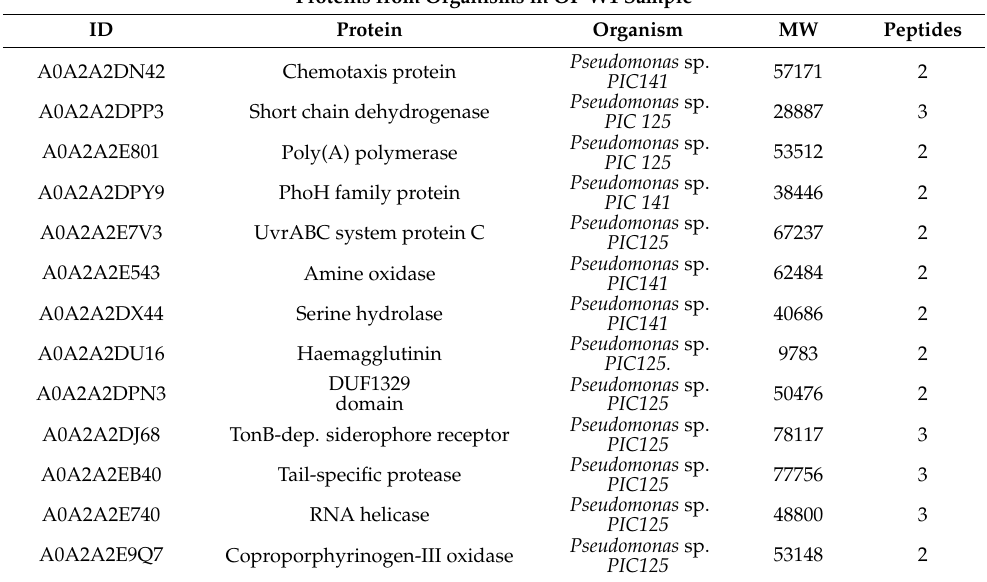
Table 8. List of identified peptides and corresponding proteins from organisms in the OP-W1 sample by LC-MS/MS analysis. The databases consulted were FASTA-file Olea and Olea europaea (common